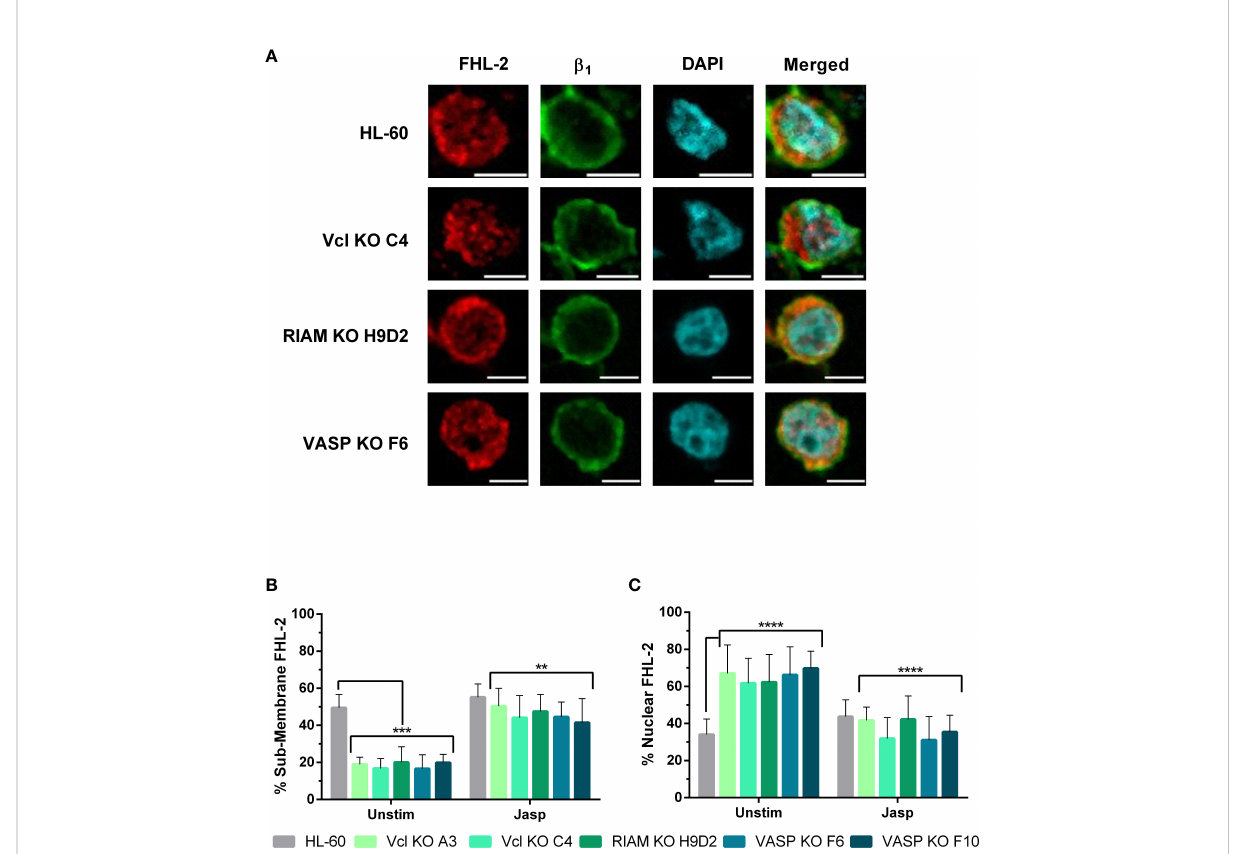
FIGURE 7 Jasplakinolide reduces nuclear localization of FHL-2 in Vinculin, RIAM and VASP knockouts. (A) Differentiated HL-60 parental cells and HL-60 knockouts for Vcl, RIAM and VASP were adhered to slides, then subjected to a 1 µ M 2 h jasplakinolide stimulation, fi xed, permeabilized and fl uorescently stained to determine FHL-2 localization. b 1 integrin was used to delimit the plasma membrane and DAPI was used as a nuclear stain. Confocal microscopy images were analyzed using the ImageJ package and are representative results from 3 independent experiments. Bars indicate 5 m m. (B, C) Subcellular distribution of FHL-2. The graphs represent the quanti fi cation of images from untreated cells shown on Figure 5 and jasplakinolide-treated cells shown on (A) . Results are represented as relative to the parental HL-60 membrane and nuclear ratio and are from 3 independent experiments with at least 50 cells. Data are presented as mean ± SD, where the error bars denote standard deviation. Signi fi cance (ANOVA) has been calculated with respect to HL-60 controls, ** denotes p<0.01, ***, p<0.005, and ****,